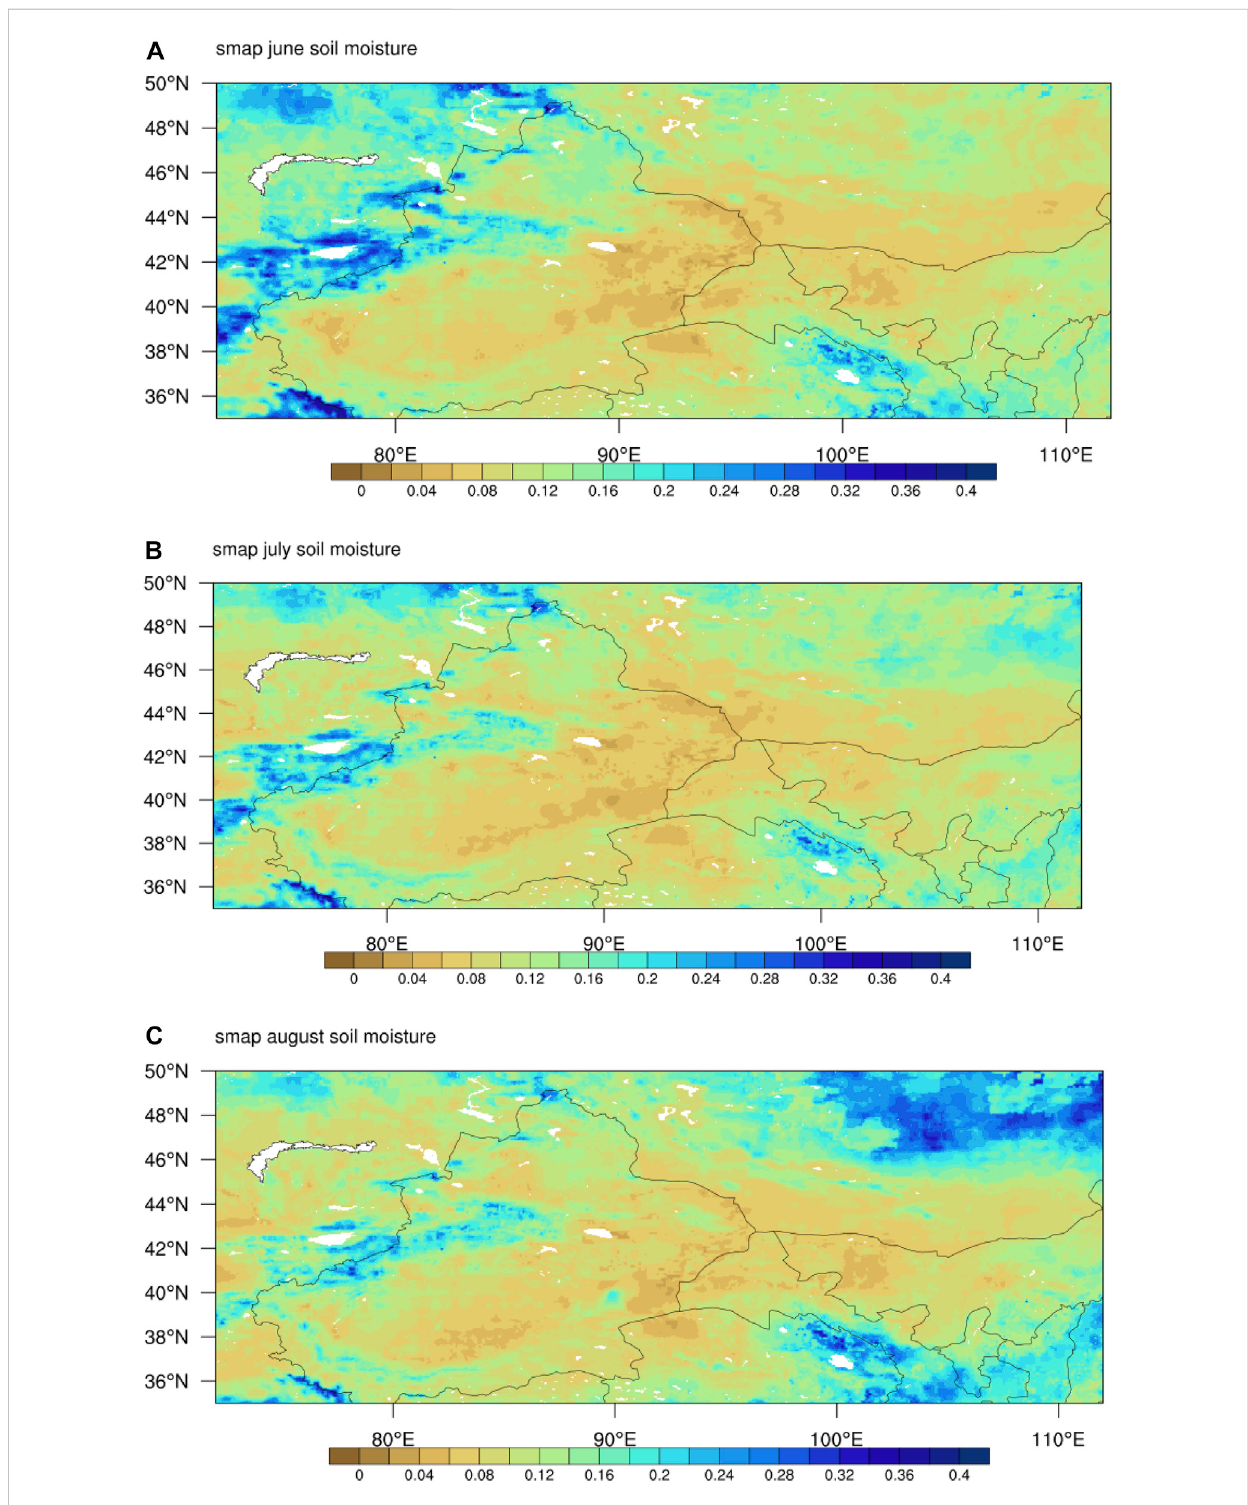
Monthly average 10-cm-deep volumetric soil moisture by SMAP L4. (A) June; (B) July; (C)